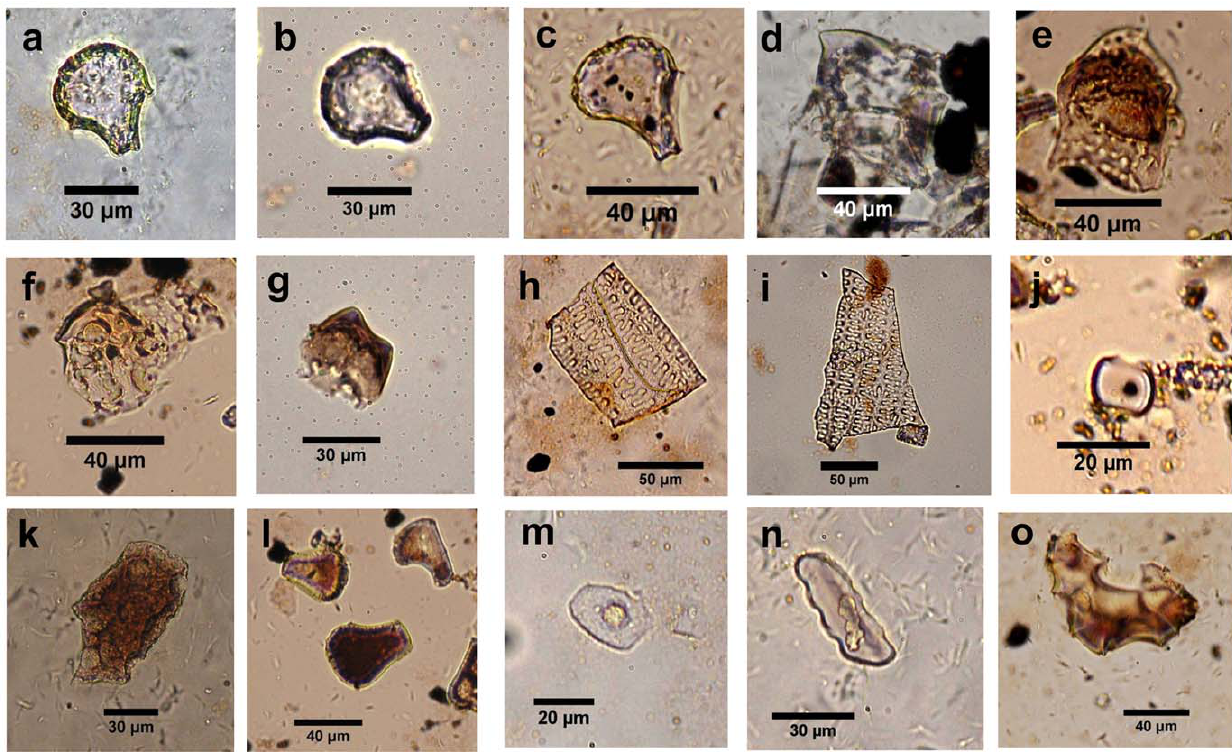
Figure 4. Main phytolith types from the Tanghu site. A–c=rice bulliform; d–g=rice double peaked; h, i=phytoliths from broomcorn millet husk; j=long saddle; k=scutiform-bulliform from reed; l=common bulliform; m= Cyperus type; n=trapeziform sinuate (tooth type); o=woody